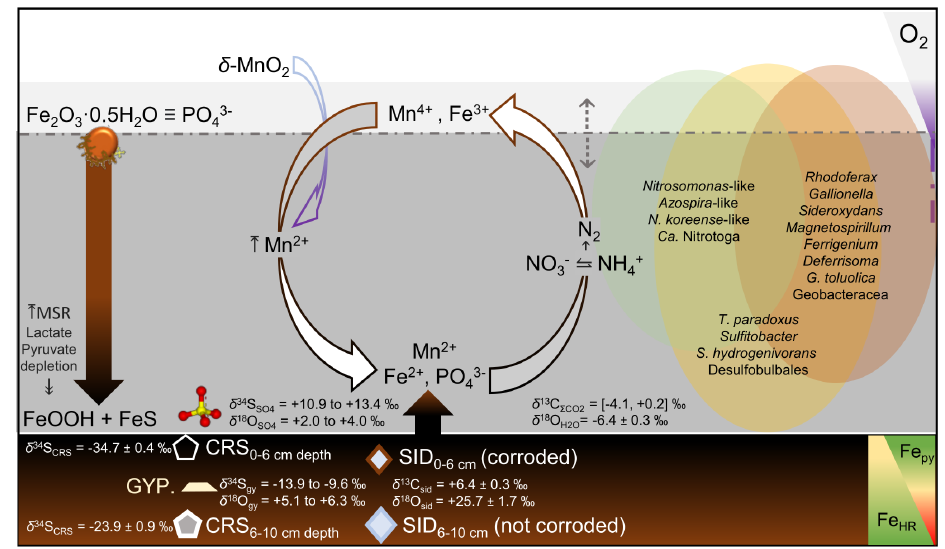
Figure 7. Scheme summarizing the speciation and stable isotopes ranges of sulfur-bearing phases (pyrite, S 0 : CRS; gypsum: GYP; siderite: SID) and the biogeochemical cycling mechanisms likely operating in the redox-stratified Lake Medard and its SWI. (Background colours as in Fig. 2.) The prokaryote groups depicted represent nitrate-, iron- and sulfur-utilizing species identified via 16S rRNA gene amplicon sequencing (see text for